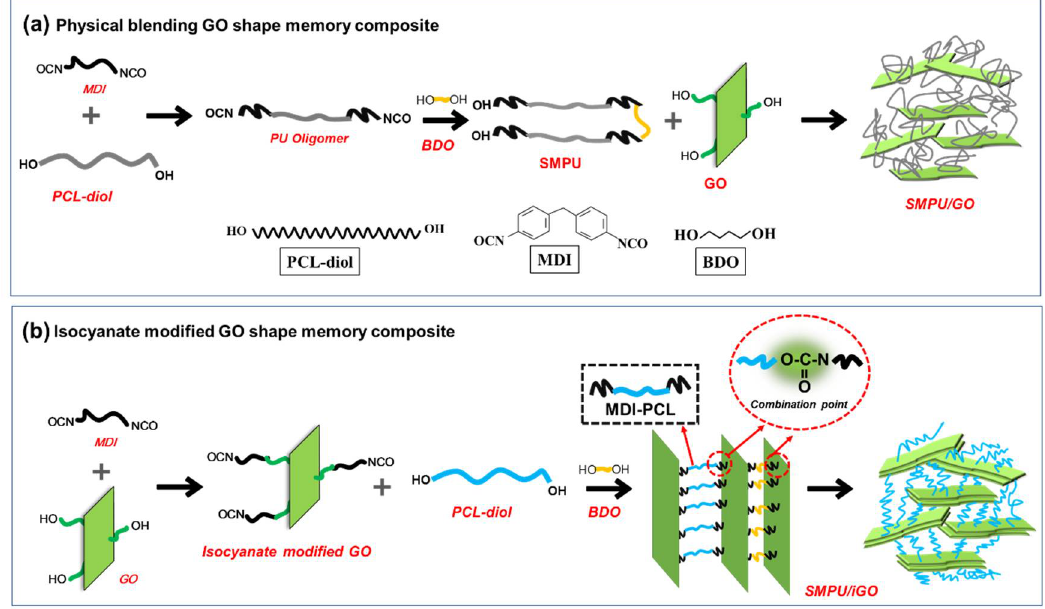
Figure 1. Preparation processes of composites: ( a ) shape-memory polyurethane (SMPU)/graphene oxide (GO) and ( b ) SMPU/isocyanate modified GO (iGO).